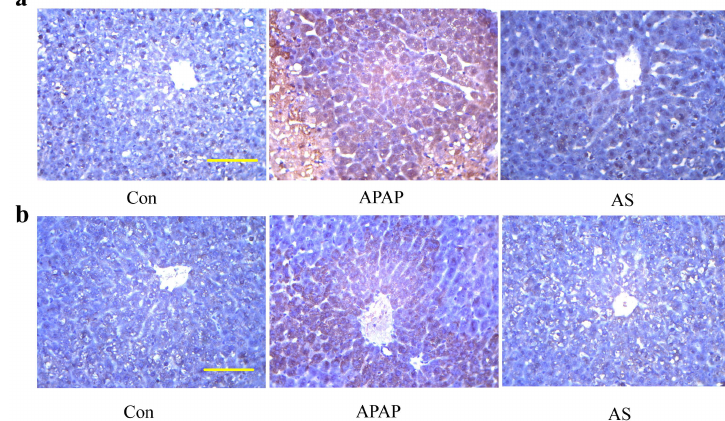
Figure 6. AS pretreatment inhibited the increases of CD45 and HNE-adducts caused by overdose APAP in mice. Analysis with immunohistochemical staining of e ff ects of AS on the expression of CD45 ( a ) and HNE-adducts ( b ). Slides were observed under 400 × magnification,scale bar: 10 µ